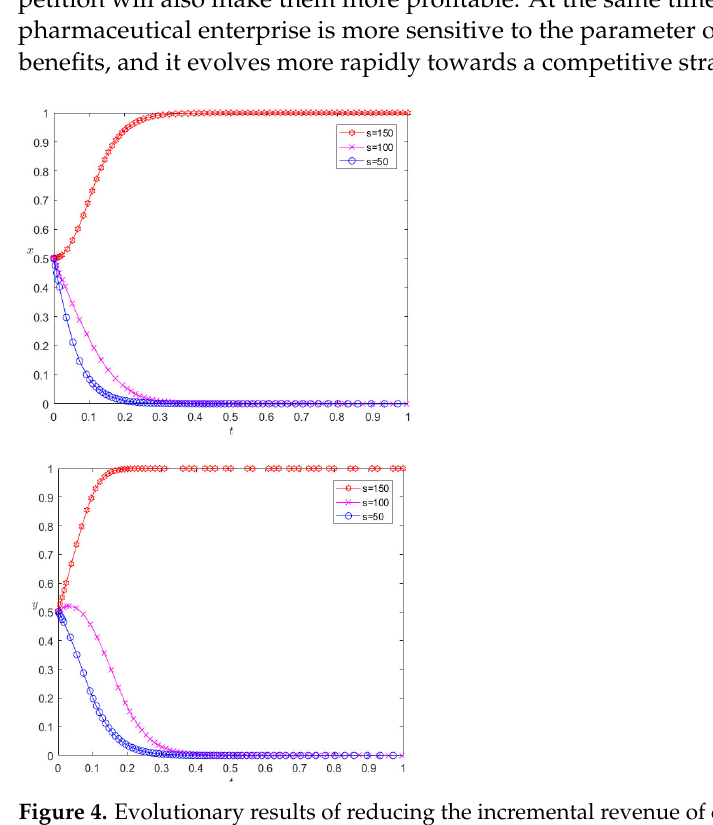
Figure 4. Evolutionary results of reducing the incremental revenue of cooperation.